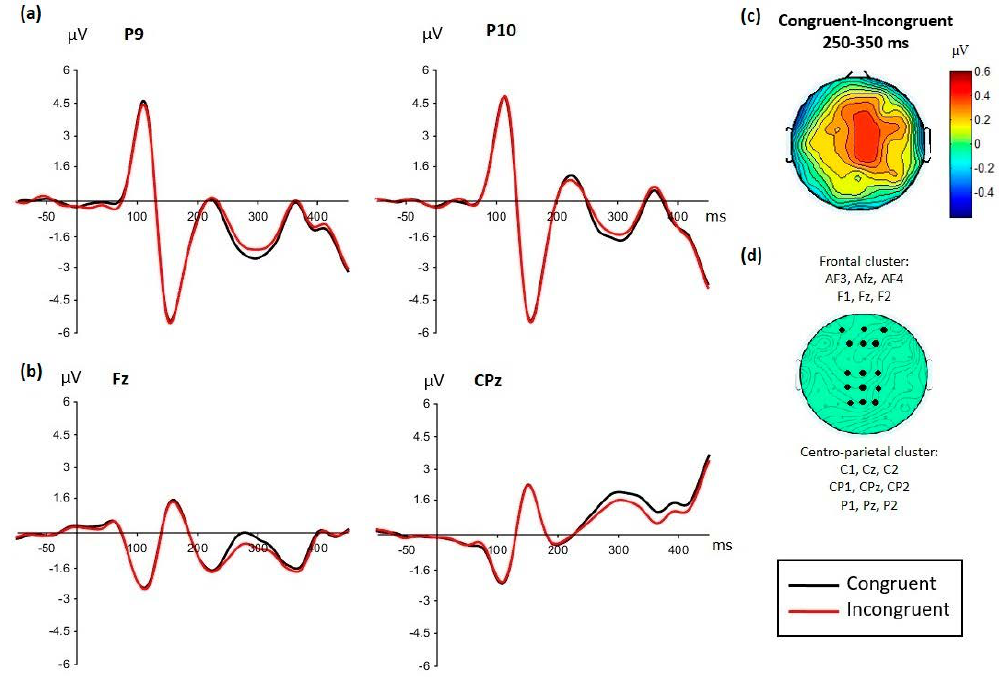
Figure 4. ( a ) Main e ff ect of congruency seen between 250 and 350 ms at posterior sites P9 / P10, with more negative amplitudes for congruent than incongruent conditions (group grand average displayed).